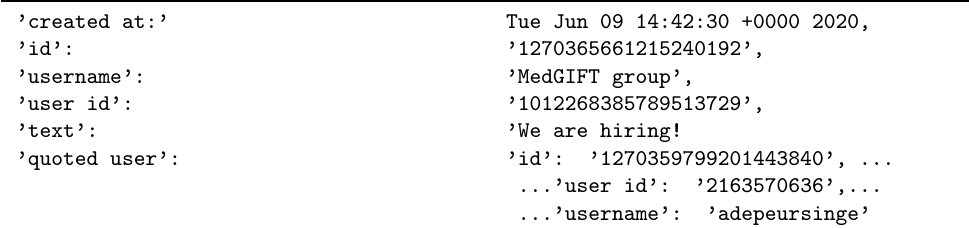
Table 2. Semi-structured network retweet